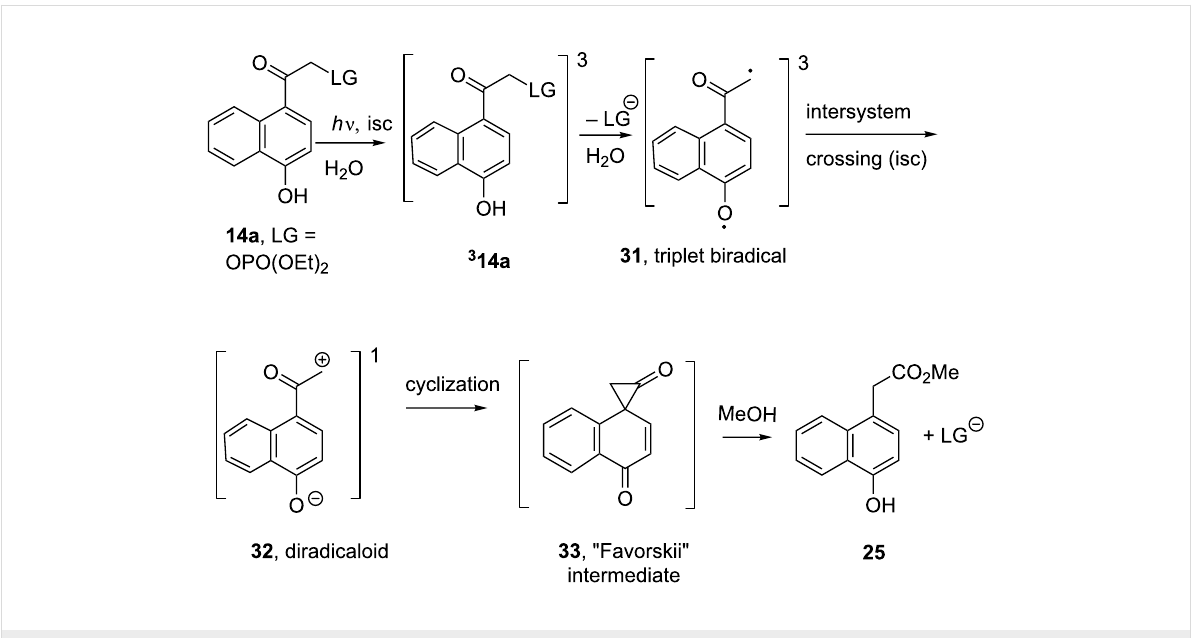
Scheme 7: Photo-Favorskii mechanism based on pHP DEP 4a photochemistry as applied to 1,4-HNA DEP ( 14a ).